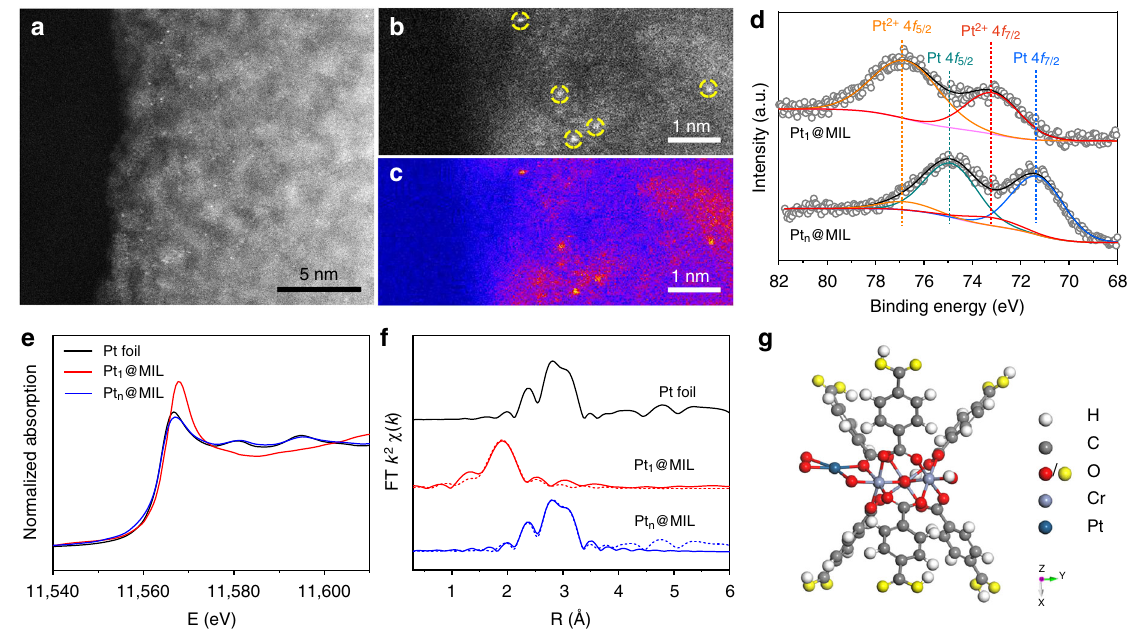
Fig. 1 Structural characterizations of Pt@MIL. a HAADF-STEM image of Pt 1 @MIL. b , c Magni fi ed HAADF-STEM image and its corresponding color-coded intensity map of Pt 1 @MIL. Pt single atoms marked in yellow circles were uniformly anchored in MIL-101. d XPS spectra of Pt 4 f for Pt 1 @MIL and Pt n @MIL. e Pt L 3 -edge XANES pro fi les of Pt foil, Pt 1 @MIL, and Pt n @MIL. f Pt L 3 -edge EXAFS spectra in R space of Pt foil, Pt 1 @MIL, and Pt n @MIL. Pt foil was used as the reference. g Structural model of Pt 1 @MIL simulated by DFT calculations. Blue, violet, red, gray, and white spheres represent for Pt, Cr, O, C, and H atoms, respectively. The yellow spheres represent the oxygen atoms which are fi xed at their positions in